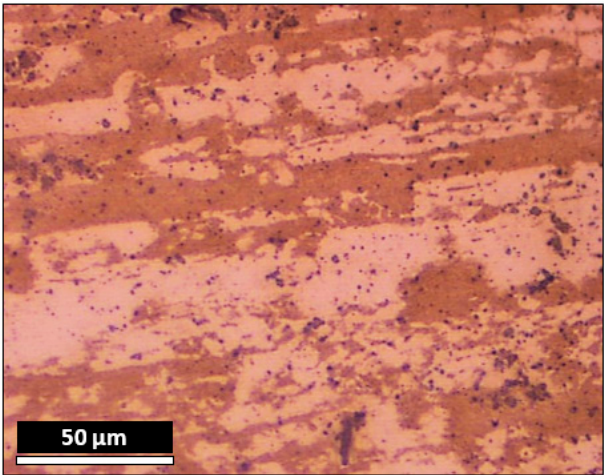
Figure 1. Microstructure of 2205 duplex stainless steel.